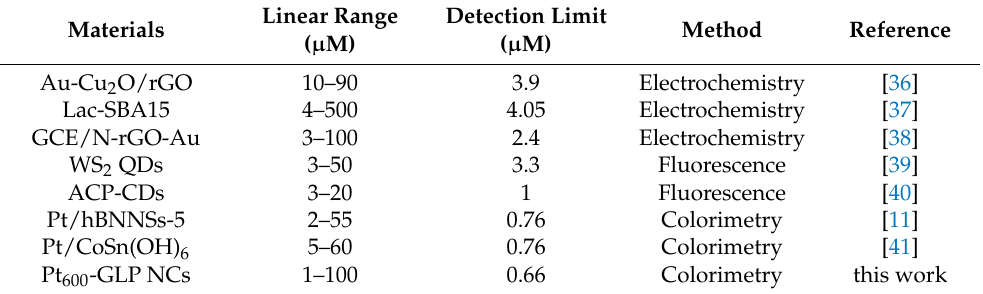
Figure 10. ( a ) The absorption spectra and ( b ) absorbance at 652 nm of mixed solutions when Pt 600 - GLP NCs and TMB systems were added by various concentrations of DA (1–250 μ M), ( c ) linear calibration chart of DA detection, and ( d ) the absorbance of dopamine (100 μ M) and other interfering substances (1200 μ M). Table 2. Comparison of the detection of dopamine using Pt 600 -GLP NCs with other reported nanozymes.